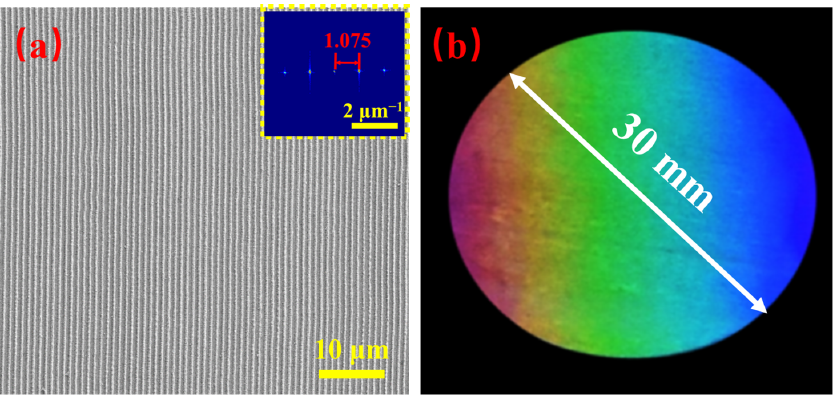
Figure 13. ( a ) SEM image of large-area regular LSFL. The scale bar is 10 µm and the inset is the 2DFT of the SEM image. ( b ) Optical image of the large-area LSFL.